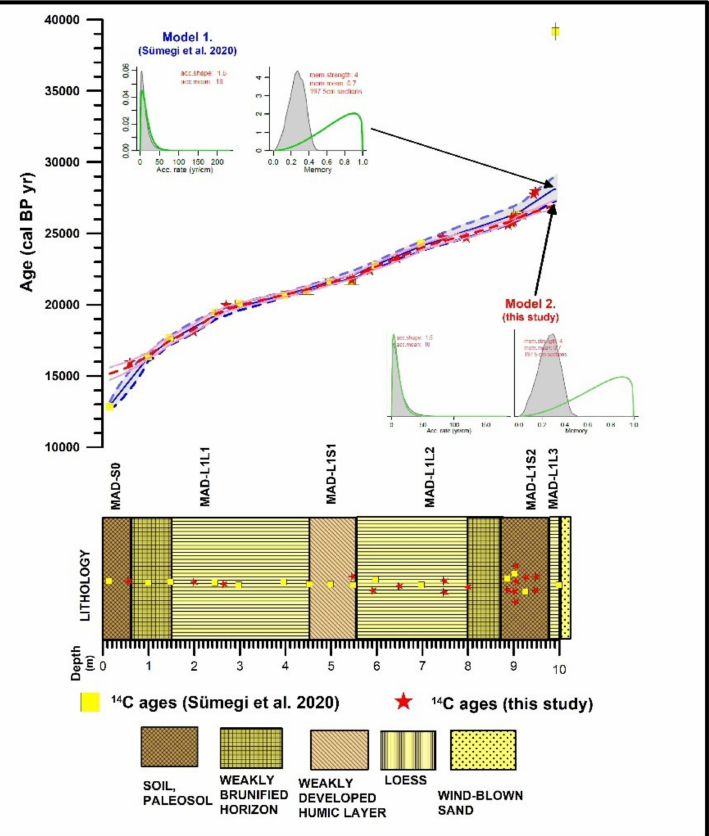
Figure 3. Comparison of constructed age-depth models of Sümegi et al. (2020) [5] (Model 1) and this study (Model 2) (squares and stars represent mean values of 14 C dated horizons included in the model, solid lines represent mean values, dotted lines and whiskers correspond to 95% confidence intervals).